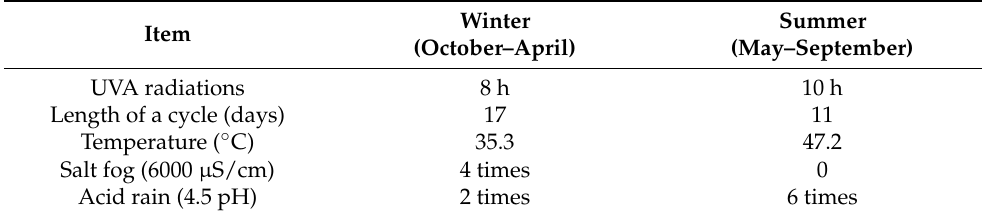
Table 1. Aging Cycles of Hattar, Pakistan.